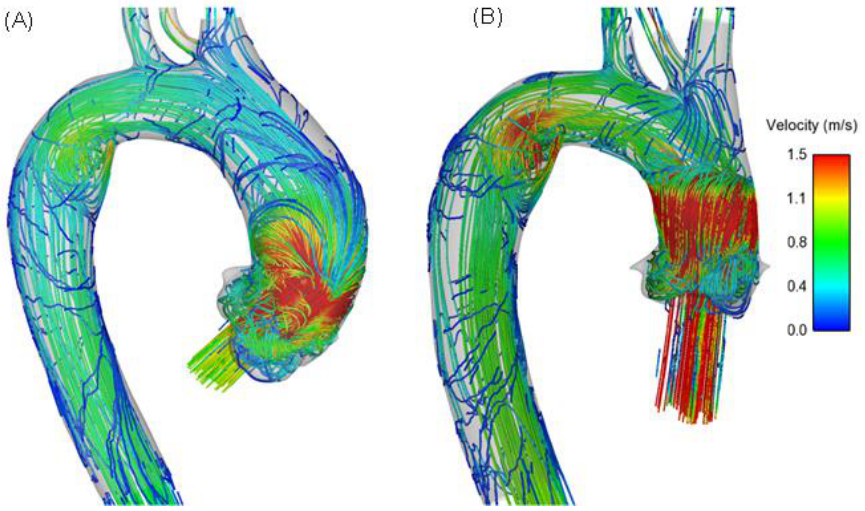
Figure 5. Flow streamlines at peak systole, as obtained from the computational modeling of ( A ) pre-operative model and ( B ) post-operative model.